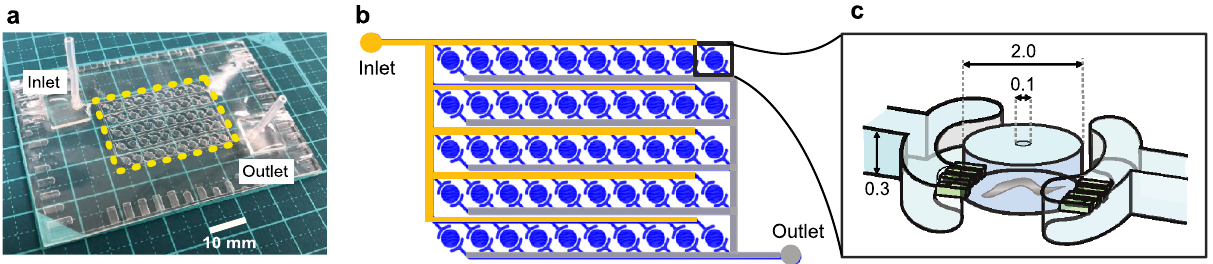
Figure 1. WormFloII microfluidic device for culturing C. elegans with food bacteria in biochemical isolation. ( a ) WormFloII photo. Inlet and outlet portals for liquid media are shown. Yellow dashed line outlines 50 chambers for individually culturing C. elegans . ( b ) WormFloII schematic. Each chamber is directly connected to supply (orange) and drain (gray) channels to achieve biochemically independent environments. ( c ) Chamber schematic. Chambers are caged with junctional micro-slit channels (50-μm width and height). Animals are introduced from 0.1-mm hole at chamber roof. Hole is shielded with PDMS sheet before supplying liquid